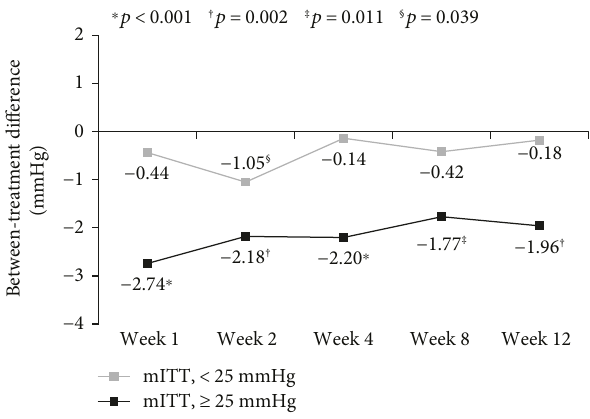
Figure 2: Between-treatment di ff erences in mean intraocular pressure (IOP) change from baseline in patients with baseline IOP ≥ 25 versus < 25 mmHg. Di ff erence=TFC − DFC. Statistical signi fi cance was determined using the 2-sample t -test. Number of